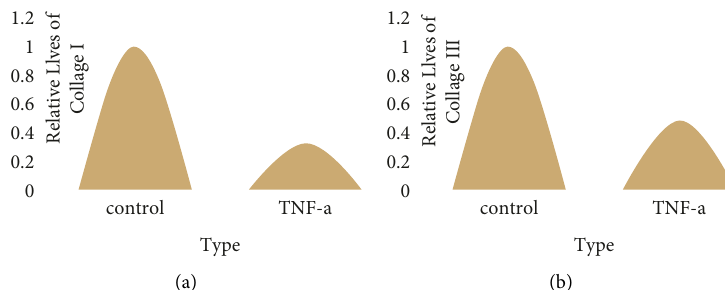
Figure 7: Effect of TNF- α (10ng/mL) on the expression of tenocyte-related genes in rats. (a) Relative longevity of type I collagen. (b) Relative longevity of type III